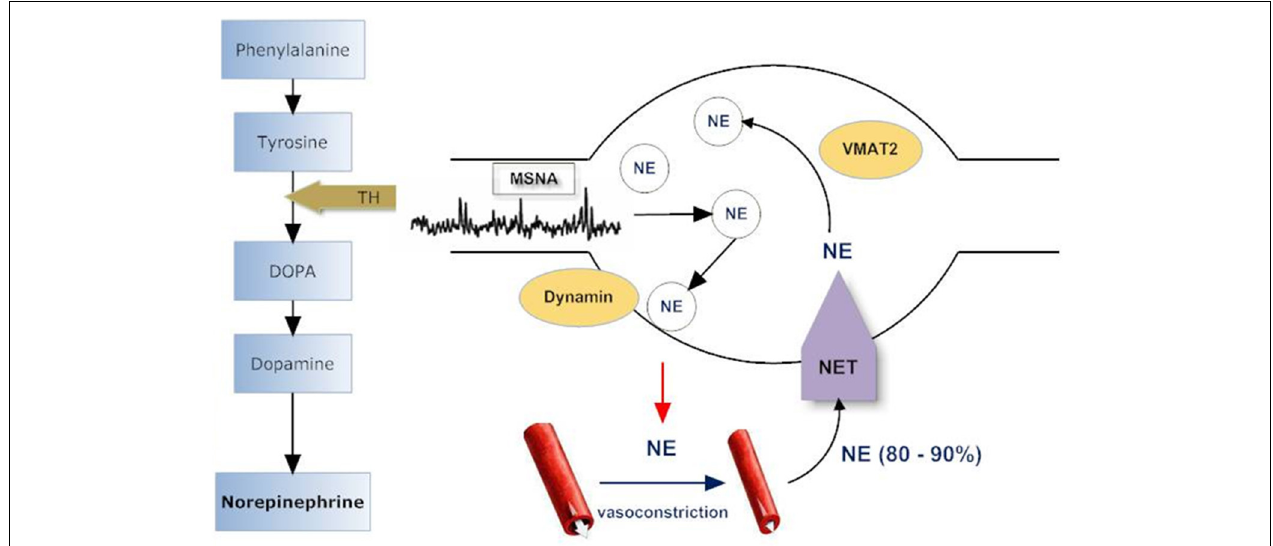
FIGURE 2 | Sympathetic nerve varicosity. Tyrosine hydroxylase (TH) catalyzes the rate limiting step in norepinephrine (NE) synthesis. NE is stored in vesicles within the sympathetic varicosity and released to effector sites such as arterioles and venules in response to muscle sympathetic nerve firing (MSNA). Norepinephrine transporter (NET) recaptures 60–95% of